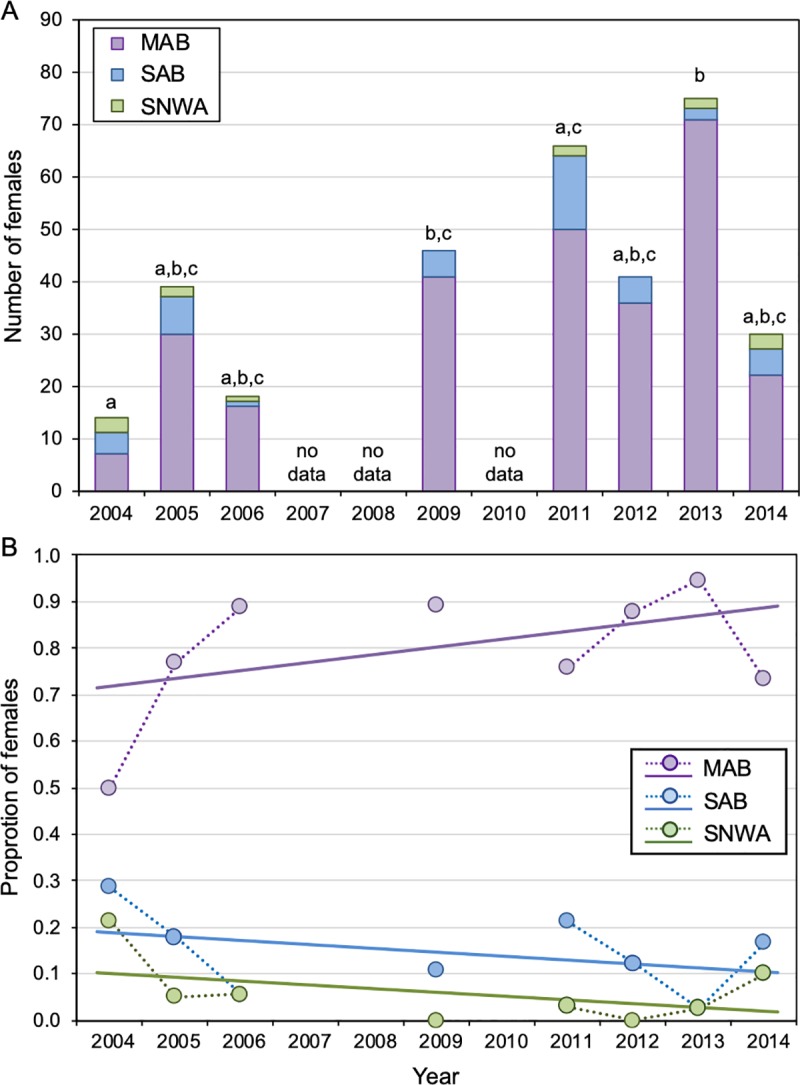
Temporal variation in foraging-area origins for Wassaw Island, GA.(A) Bar chart and (B) line graph displaying temporal variation in the proportion of female loggerheads nesting on Wassaw Island, GA originating from three different foraging areas: MAB, Mid-Atlantic Bight; SAB, South Atlantic Bight; SNWA, Subtropical Northwest Atlantic. (A) Letters indicate statistical differences among sampled years (Pearson’s Chi-squared tests; all pairwise comparisons). (B) There were no significant trends over time in the proportion of females originating from the three foraging areas (generalized least squares with first order autocorrelated error structure; one analysis for each of the three foraging areas). Previously published data were included for 2004–2011 from Vander Zanden et al. [15] and 2014 from Price et al. [29].